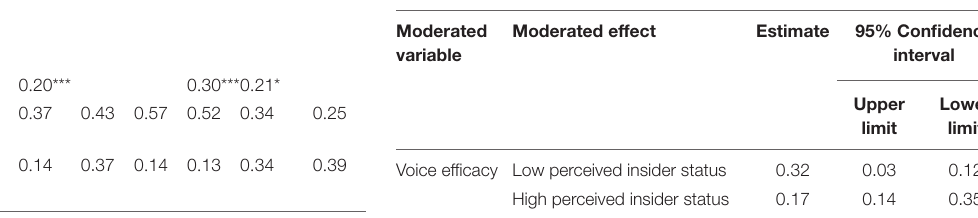
TABLE 4 | Moderated mediating Monte Carlo